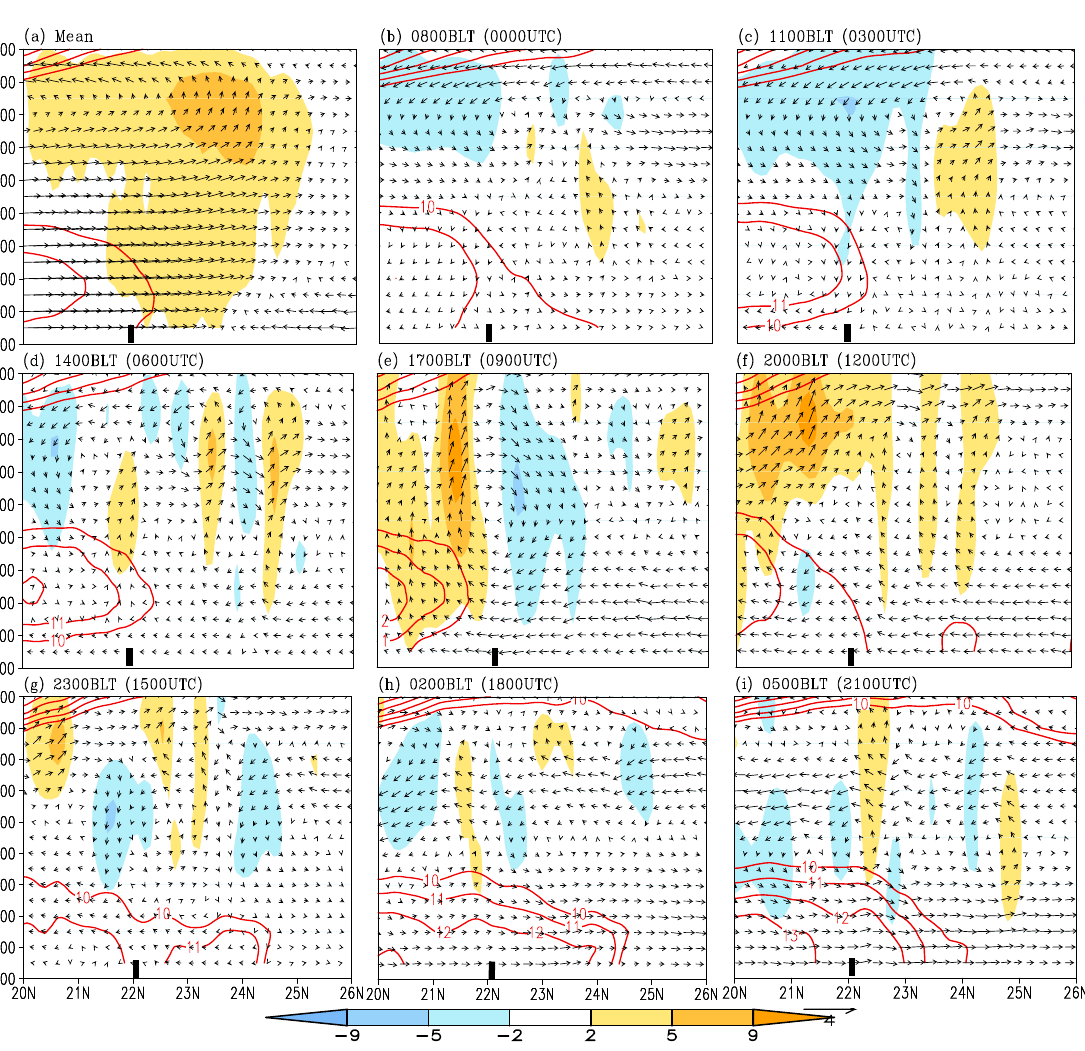
Figure 14. Exp NLS simulation of mean vertical velocity (shaded, unit: 10 –2 m·s –1 ) and height-latitudinal circulation ( v , w ) ( a ) and the diurnal evolution of anomalous vertical velocity (shaded, unit: 10 –2 m·s –1 ) and height-latitudinal circulation ( v , w ) averaged over 112–114°E for the 10-day period at ( b ) 0800 BLT, ( c ) 1100 BLT, ( d ) 1400 BLT, ( e ) 1700 BLT, ( f ) 2000 BLT, ( g ) 2300 BLT, ( h ) 0200 BLT and ( i ) 0500 BLT. Units v and w are in m·s –1 ; w is multiplied by 20. The contour interval is one, and only those horizontal winds greater than 10 m·s –1 are shown. The black bar roughly demonstrates the land-sea